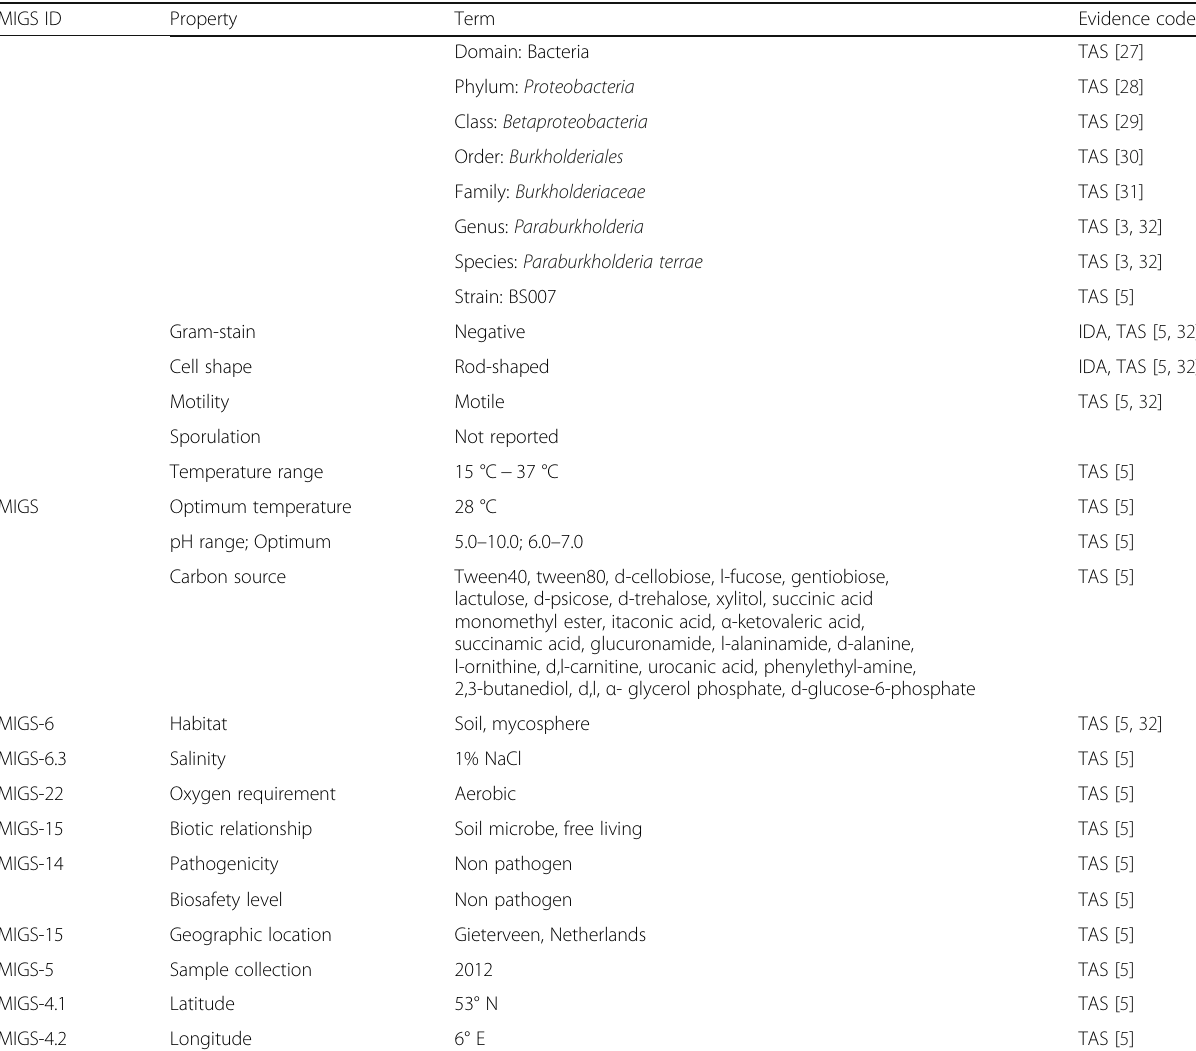
Table 2 Classification and general features of Paraburkholderia terrae strain BS007